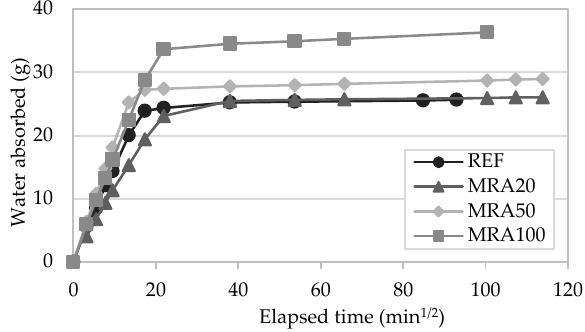
Figure 9. Water absorption by capillarity action tests results of MRA mortars.